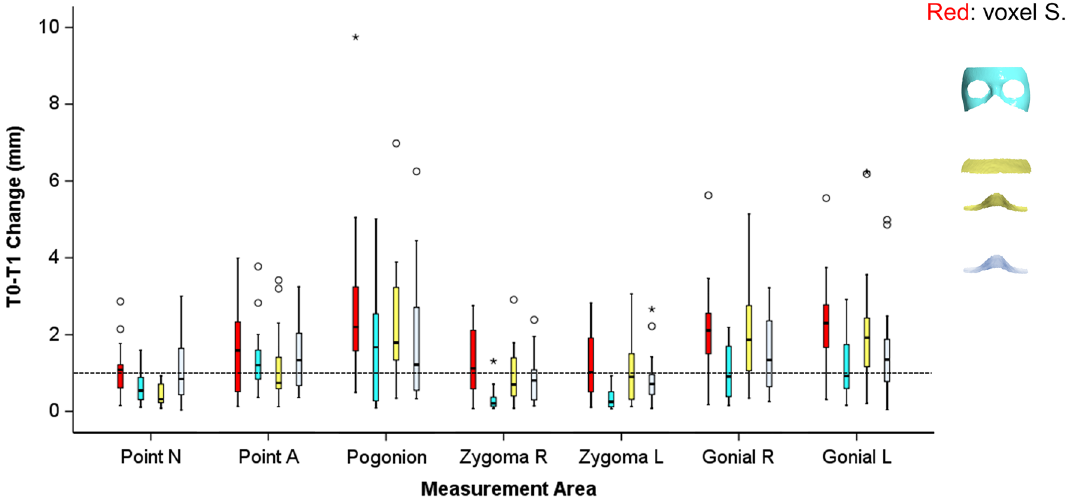
Figure 4. Box plots showing in the y-axis the T0-T1 changes detected through the anterior cranial base voxel-based superimposition and the three surface-based superimpositions. The upper limit of the black line represents the maximum value, the lower limit the minimum value, the box the interquartile range, and the horizontal black line the median value. The dashed horizontal line indicates changes of 1 mm. Outliers are shown as black circles or asterisks, in more extreme cases, with a step of 1.5 × IQR (interquartile range).